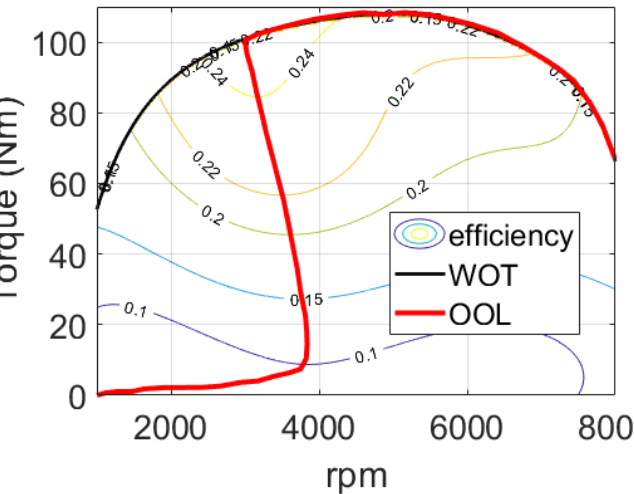
Figure 5. WOT torque curve (black line), efficiency map (isoline map), and OOL(red line) of the Wankel engine at sea level.